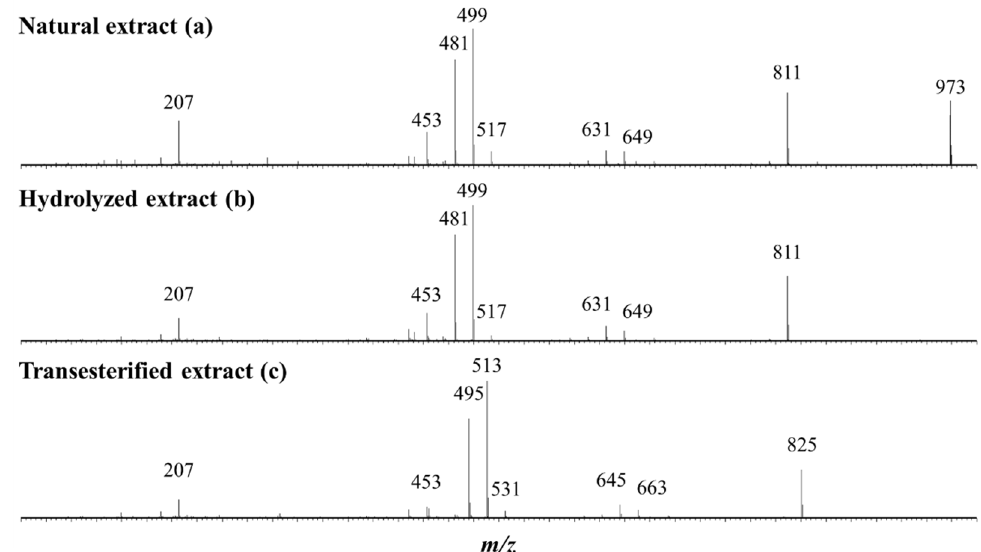
Figure 5. LC-MSMS analysis of the ( a ) natural extract, ( b ) hydrolyzed extract, and ( c ) transesterified extract. Collision-induced dissociation (CID) mass spectra of the ( a ) m / z 973, ( b ) m / z 811 and ( c ) m / z 825 precursor ions, respectively, corresponding to the [M + H] + ions of ( a ) Saponin B, ( b ) hydrolyzed Saponin B, and ( c ) transesterified Saponin B.